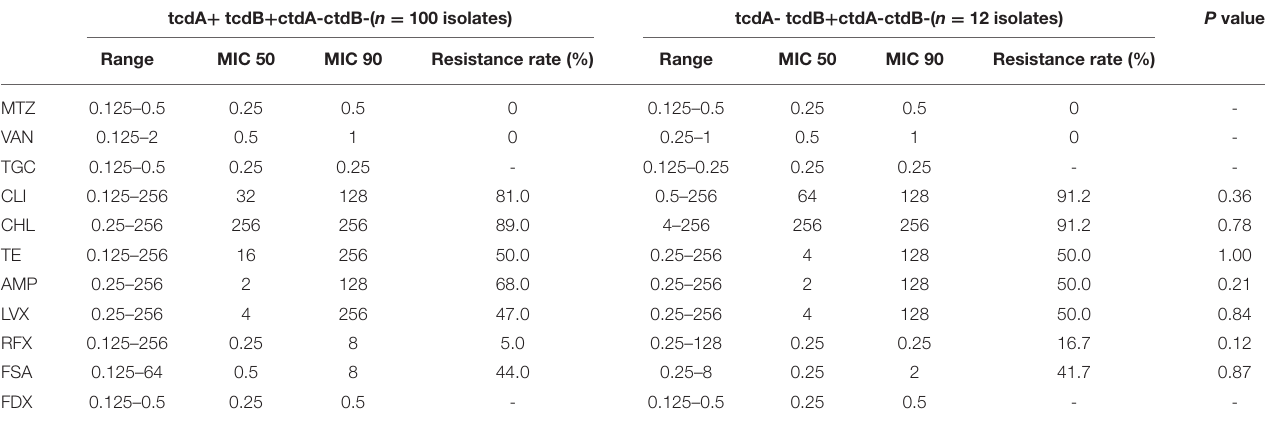
TABLE 3 | The antibiotic resistance of C. difficile isolates according to toxin